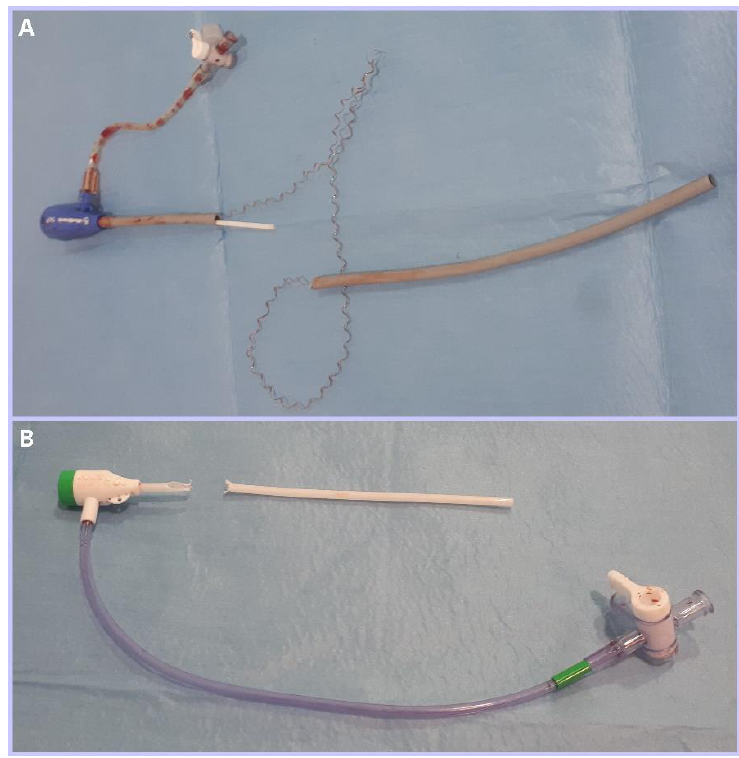
Figure 1. Severed femoral sheath and its relation to the Medtronic Sentrant introducer sheath (14 French): ( A ) position in the introducer sheath; ( B ) two parts of the severed sheath.